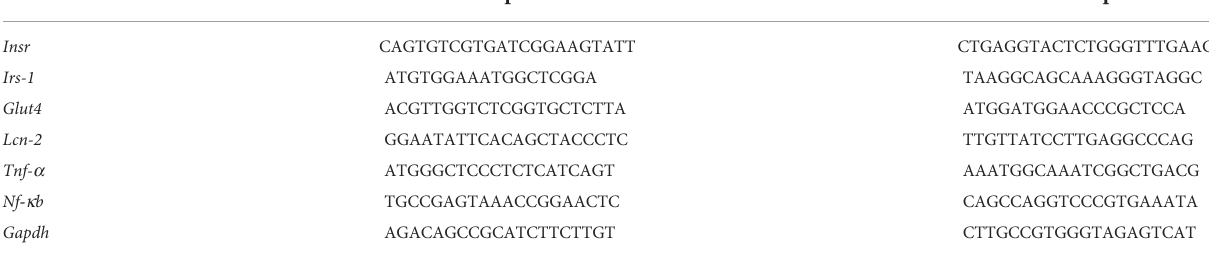
TABLE 1 Primer sequences for qRT PCR